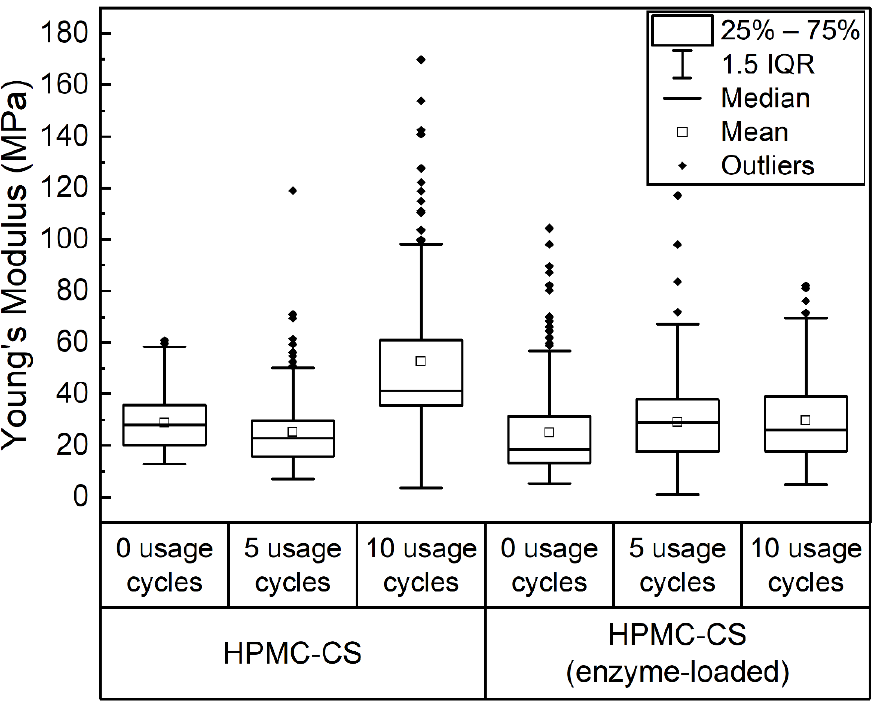
Figure 8. Box plot displaying Young’s modulus values obtained from HPMC–CS films (with and without enzyme loading) before usages, and after 5 and 10 usage cycles. Each plot indicates the distribution of 225 datapoints collected from measurements across a 3 × 3 mm area of film.